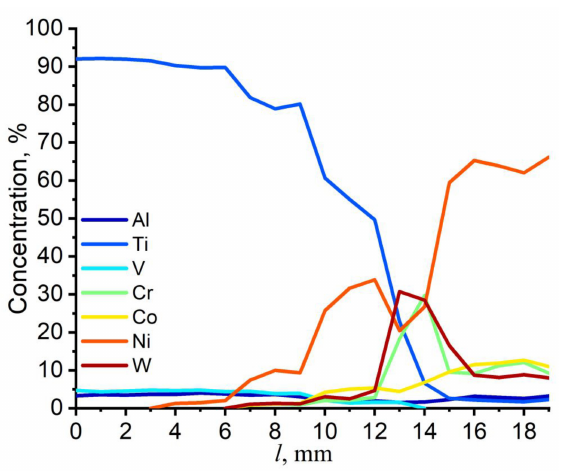
Figure 19. EDS element profiles obtained along trajectory 6 in Figure